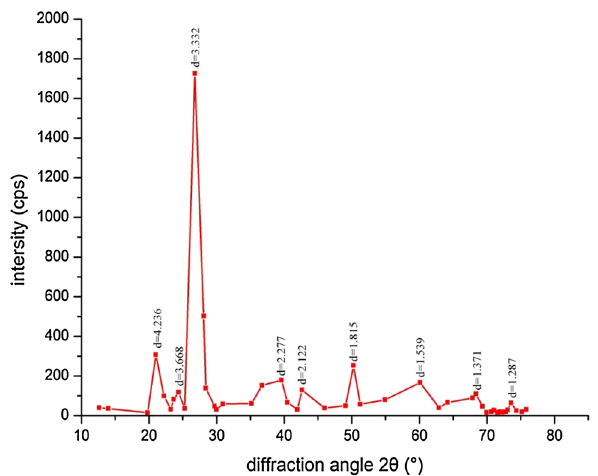
Fig. 8 Peak on XRD spectrum of cuttings